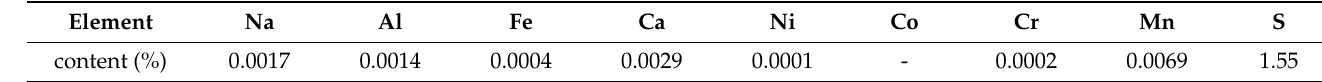
Table 3. Element analysis of MgO after calcination of Mg(OH) 2 .